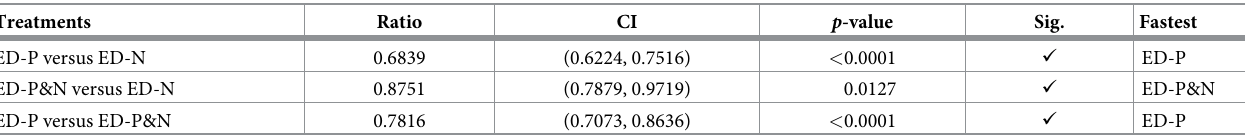
Table 6. ED : Set cardinality time analysis.